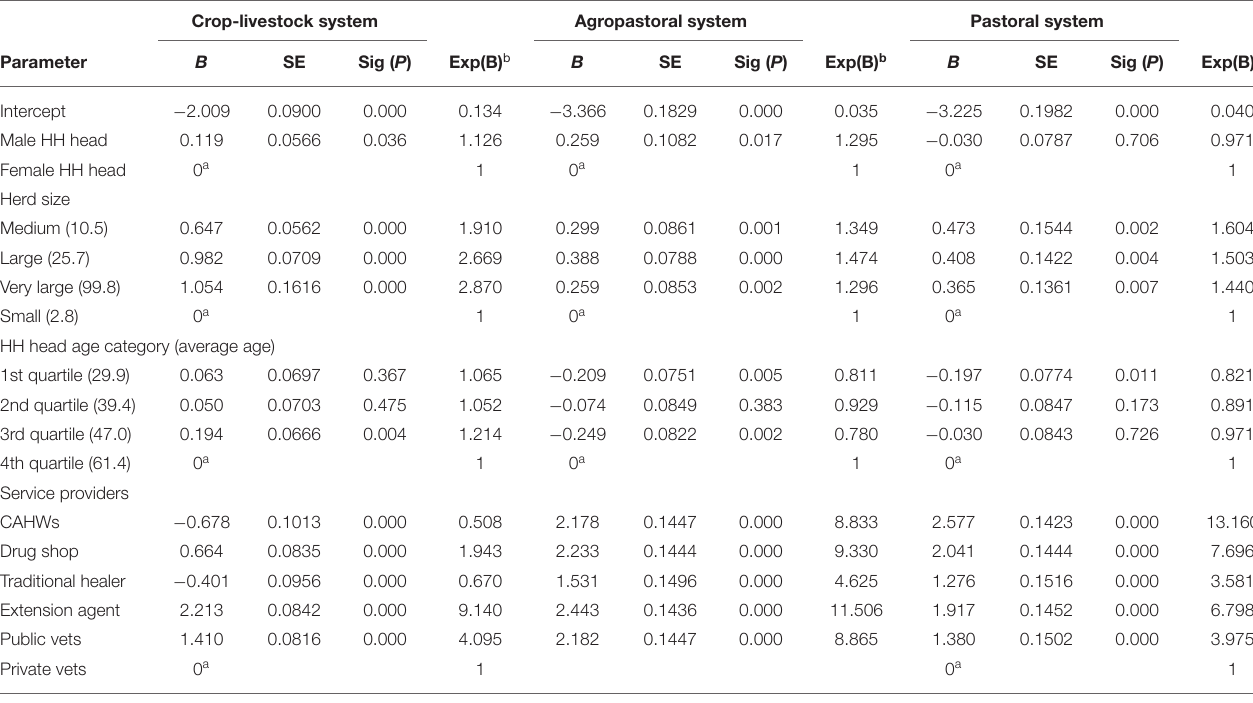
TABLE 5 | Biogeographic, socioeconomic, and institutional determinants of access to animal health services in mixed crop-livestock, agropastoral and pastoral livestock production systems in Ethiopia. Crop-livestock system Agropastoral system Pastoral system